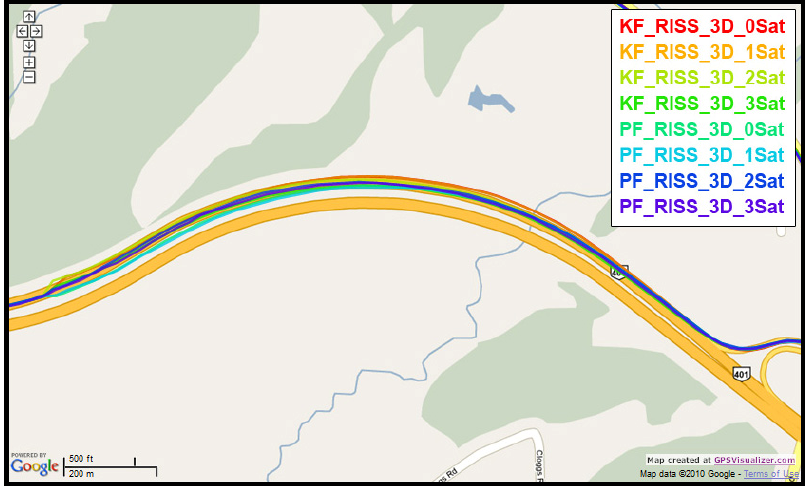
Figure 5. Performance during the simulated GPS outage #5 of the first trajectory.